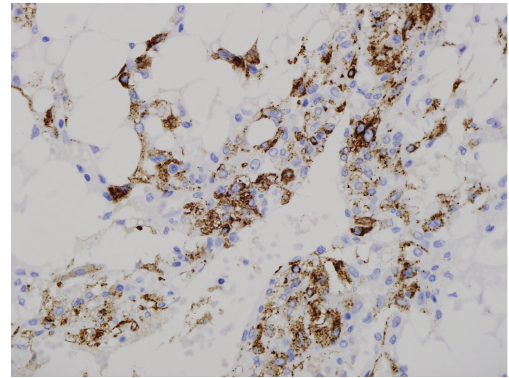
Figure 4: Typical HMB45 staining of liver